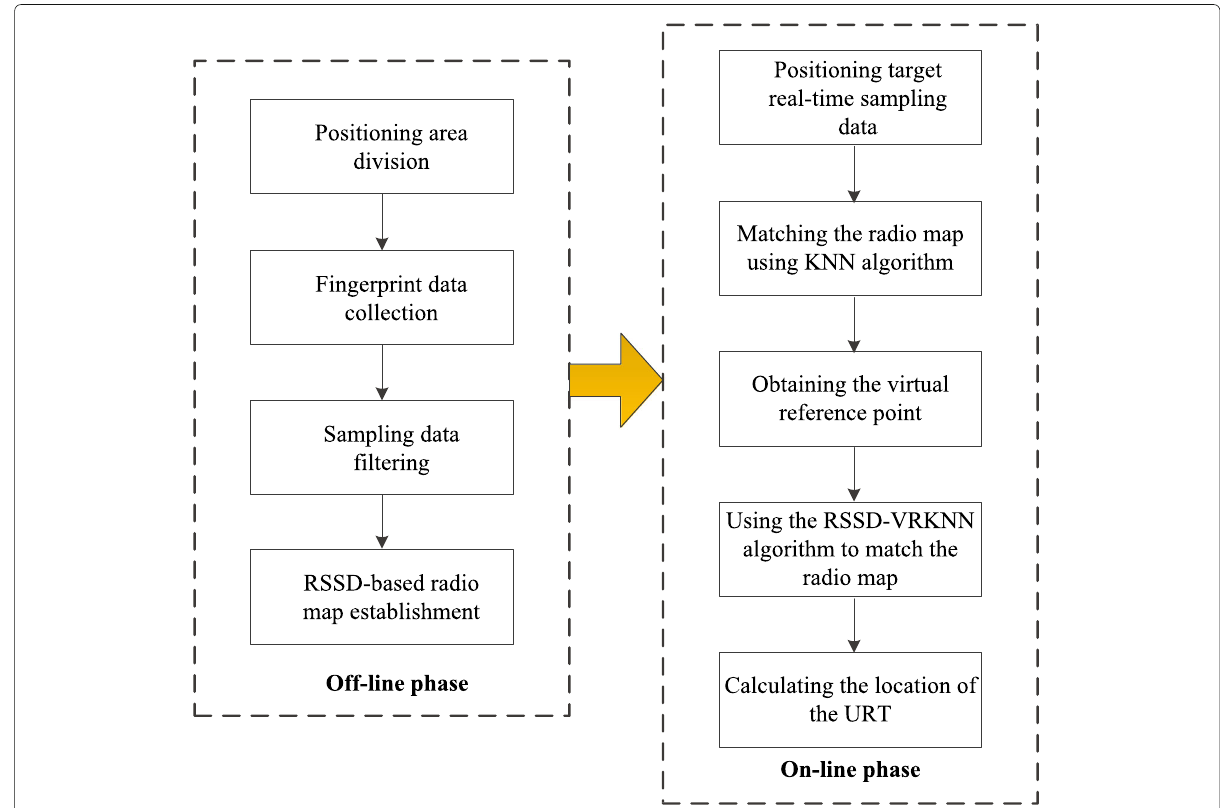
Fig. 2 Process of the RSSD-VRKNN positioning system. Off-line phase: RSSD-based fingerprint database is established. On-line phase: when the URT enters the positioning area, real-time RSSD is obtained and matched with the RSSD in the database